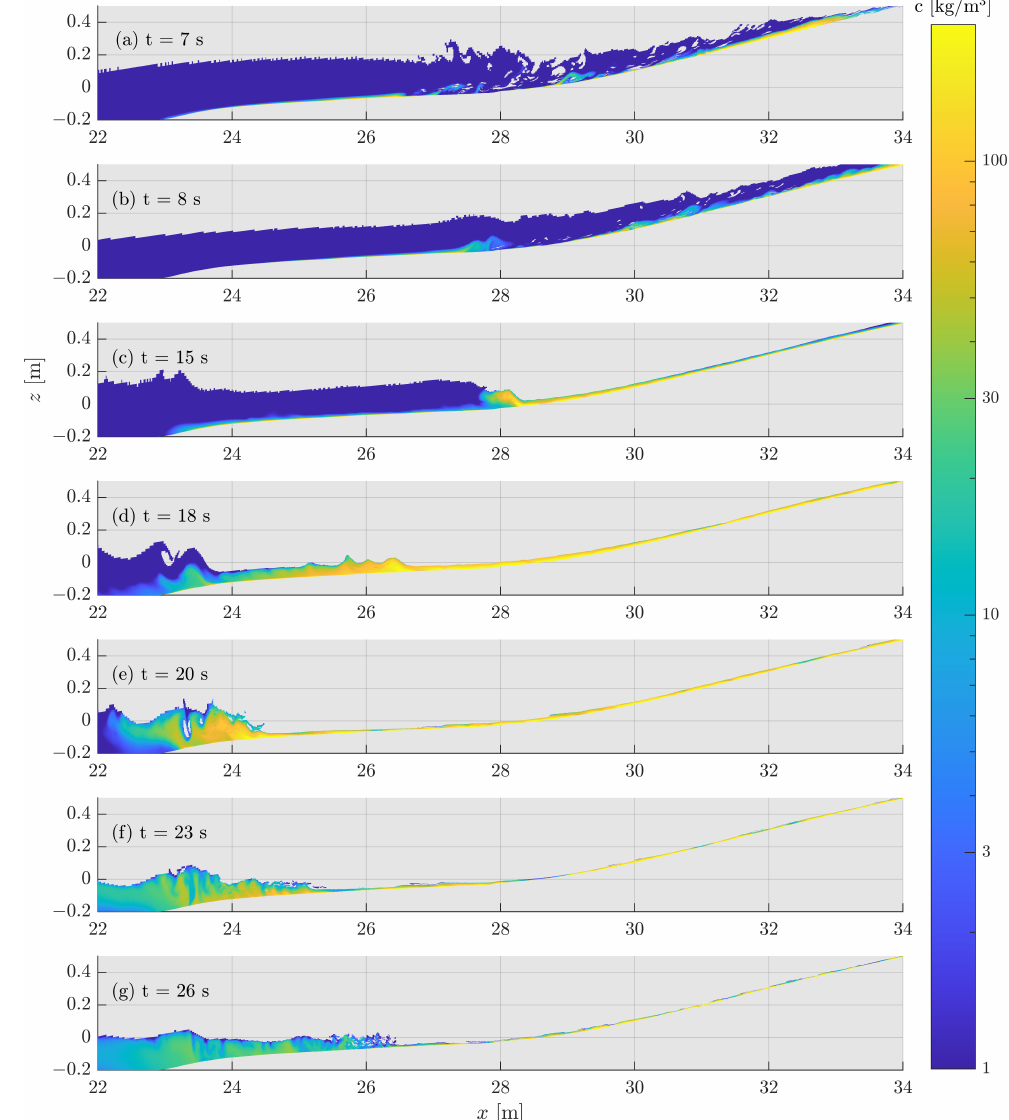
Figure 13. Figure showing snapshots at different times of the sediment concentration in the water. Here only cells containing at least 50% water are